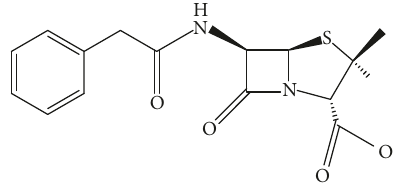
Figure 1: Structural formula of Penicillin G.